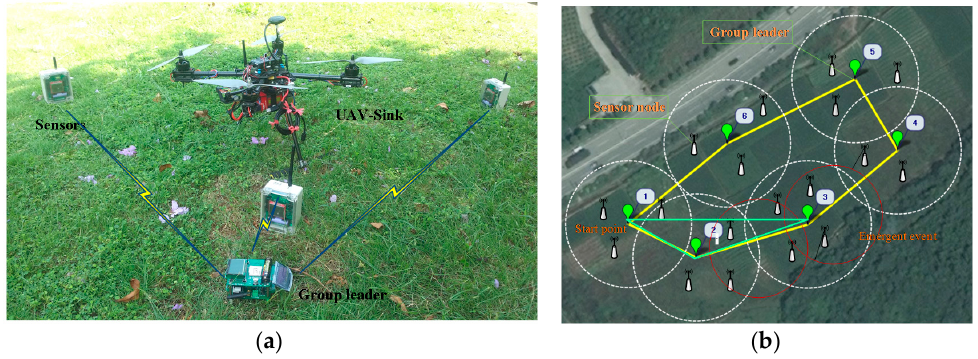
Figure 6. Multi-motor UAV sink. Right Flight path of UAV. ( a ) Implement scene; ( b ) UAV-Sink flying path in different ways. Note that, in Figure 6b, the yellow and green line indicate flying path using traditional means and our proposal, respectively. Red circles stand for emerging events.